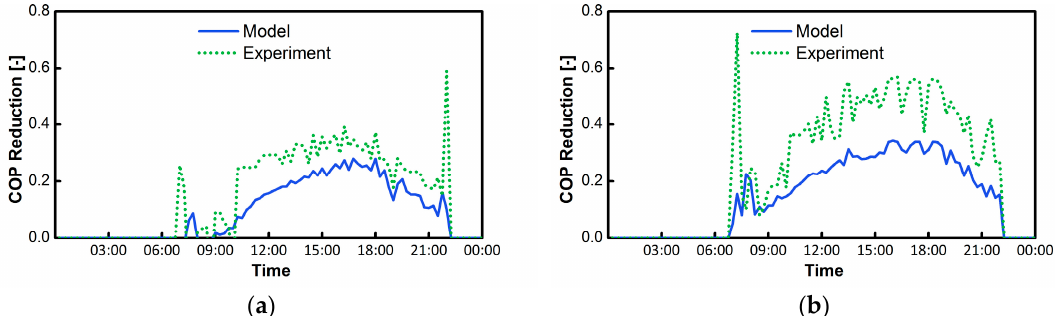
Figure 10. Reduction of COP in faulted scenarios: condenser fouling. ( a ) 28% fouling; ( b ) 58% fouling.